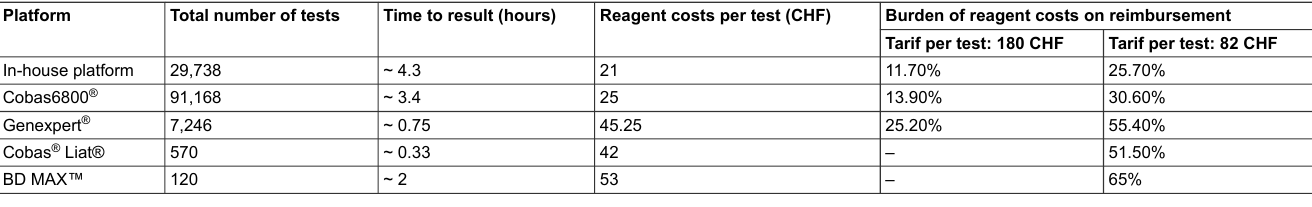
Table 1: Reagent costs for different molecular platforms and the percentage these costs account for of the reimbursement per test according to the official tariff during the first wave (180 CHF) and during the last two months of 2020 (82 CHF).